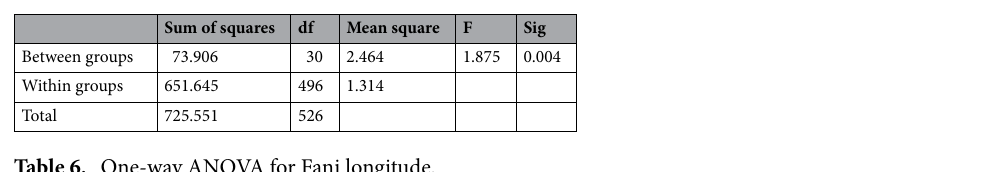
Table 6. One-way ANOVA for Fani